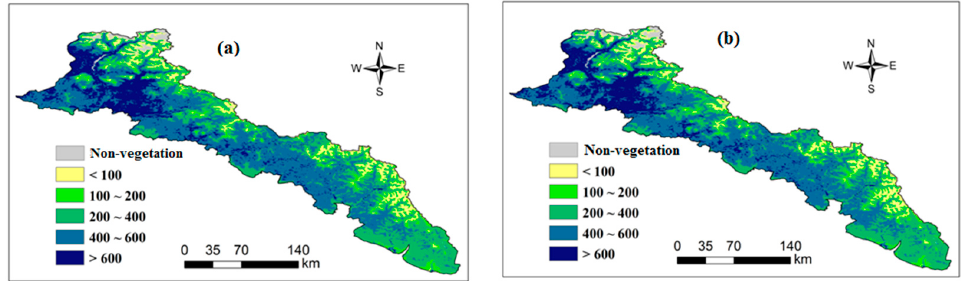
Figure 2. Overall characteristics of annual GPP ( a ) and growing season GPP ( b ) in the Altay Mountains.